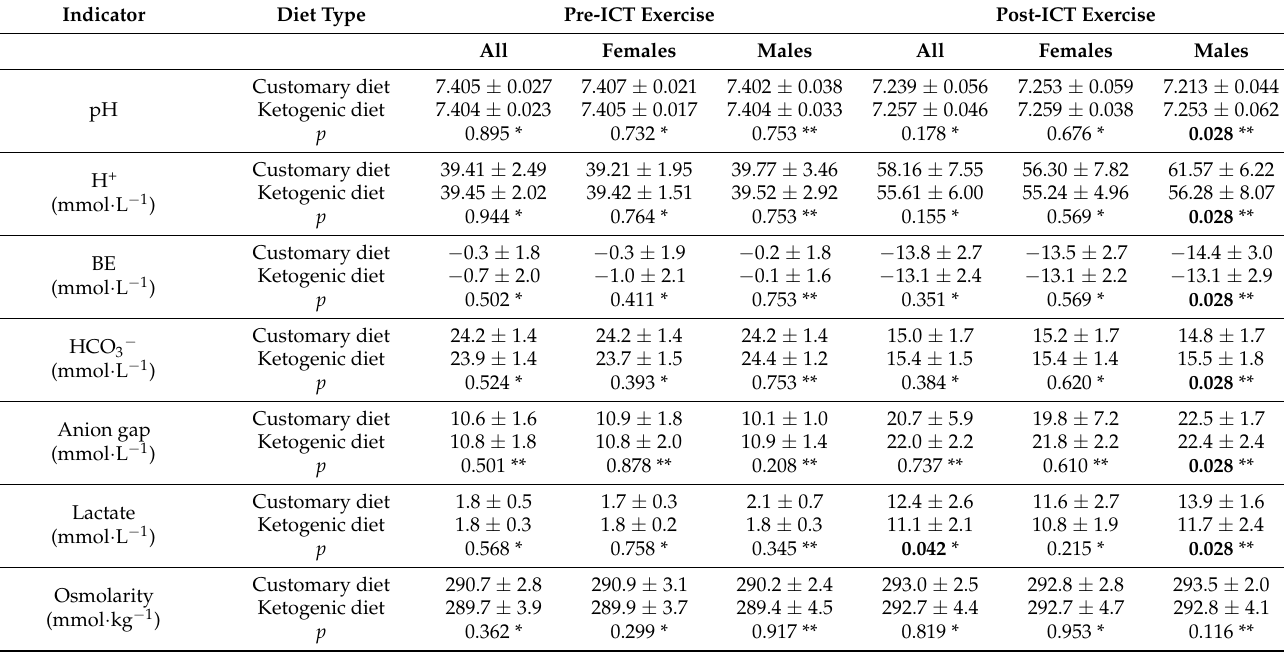
Table 3. Blood acid–base